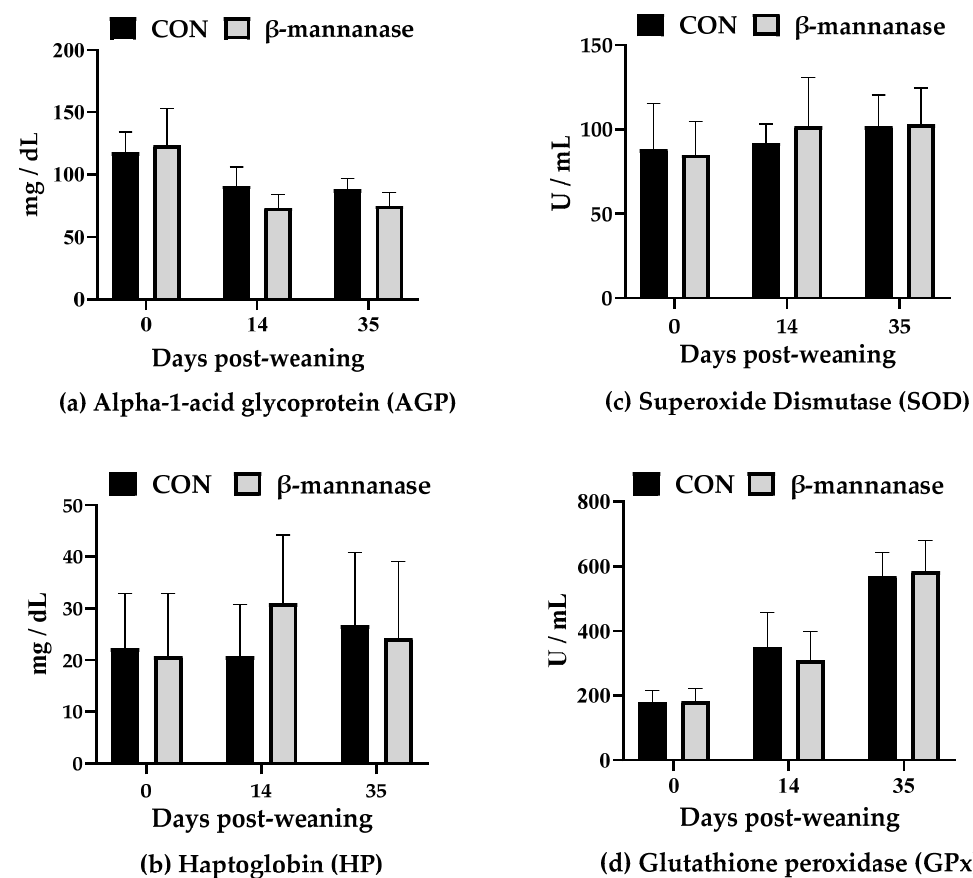
Figure 1. E ff ects of dietary supplementation of β -mannanase on serum acute phase proteins (( a ) AGP, and ( b ) HP)) and oxidative status markers (( c ) SOD, and ( d ) GPx)) of weaning pigs.